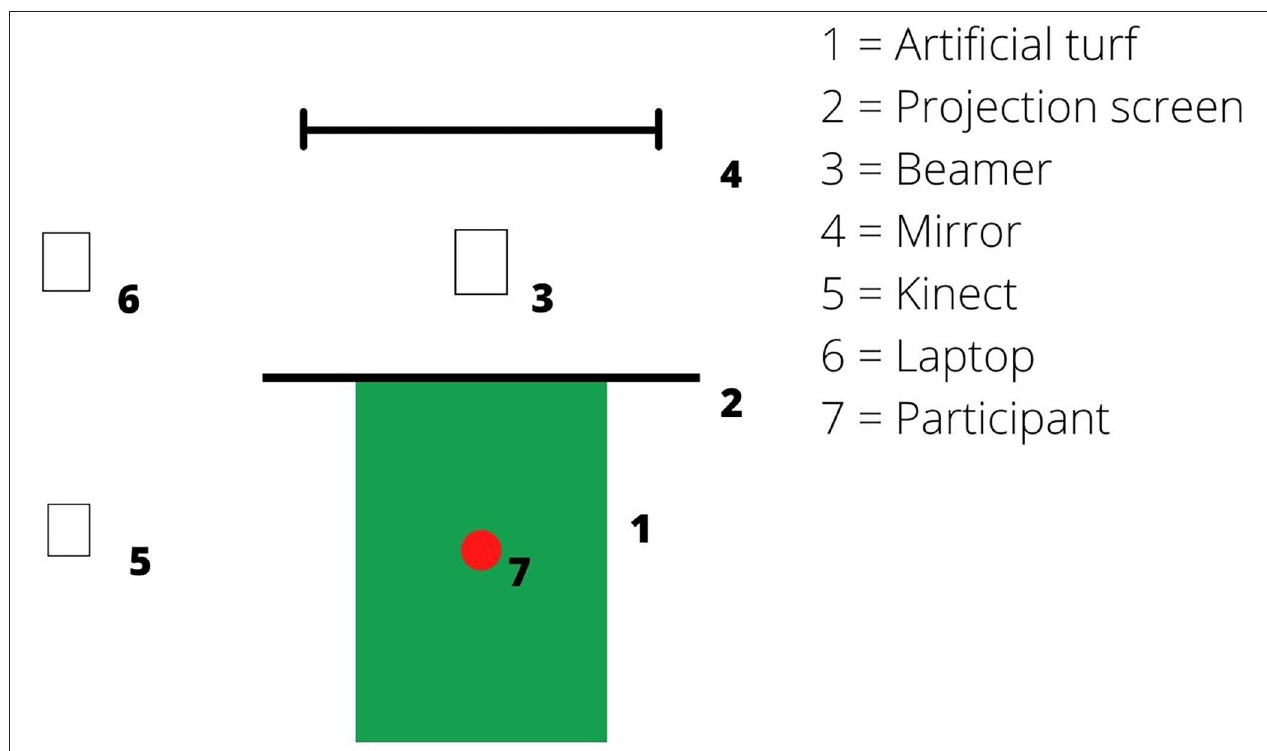
FIGURE 1 | Bird-eye view of the video task